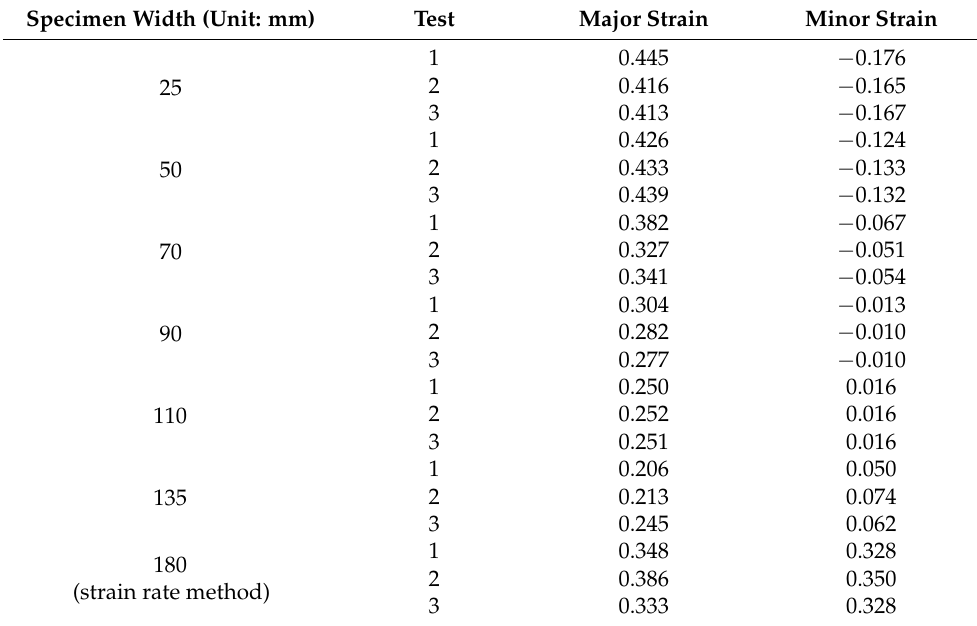
Table 4. Summary of the forming limit strain of high-strength steel sheet.